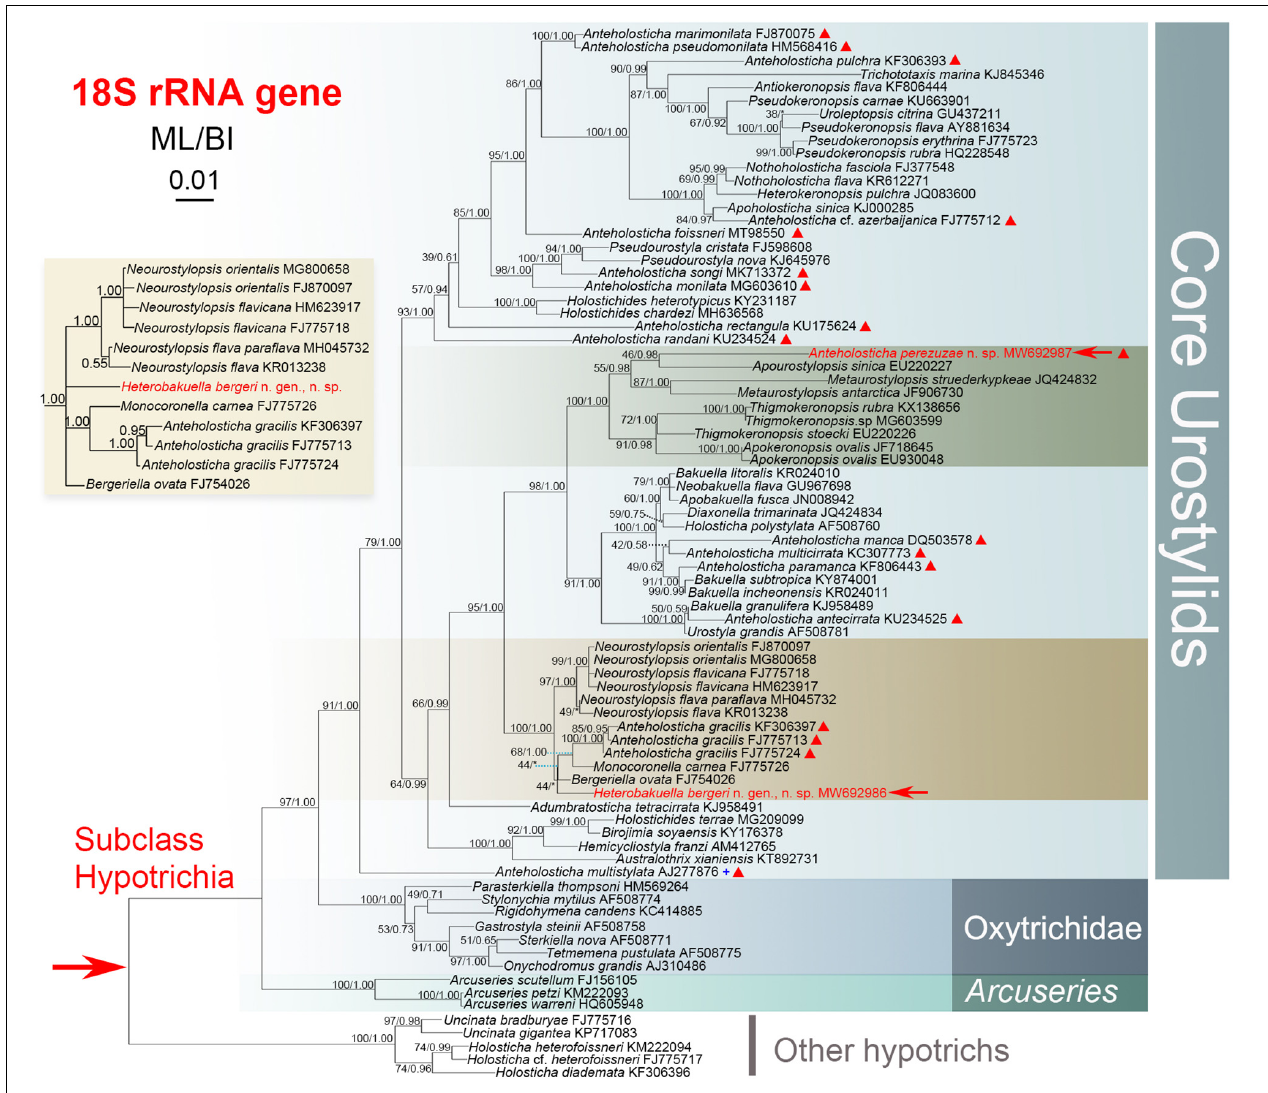
FIGURE 6 | Maximum-likelihood (ML) tree inferred from 18S rRNA gene sequences, showing the systematic positions of Heterobakuella bergeri gen. nov., sp. nov. and Anteholosticha perezuzae sp. nov. (indicated in red). An inserted branch of Heterobakuella bergeri gen. nov., sp. nov. in Bayesian inference (BI), showing the systematic position of H. bergeri . Numbers near branches denote bootstrap values for ML and posterior probabilities for BI. Asterisks (*) indicate the disagreement between ML and BI trees and triangles indicate Anteholosticha species. The population of Anteholosticha multistylata marked with the plus (+) symbol was from NCBI without published morphological data. GenBank accession numbers are provided after species names. All branches are drawn to scale. The scale bar represents one substitution per 100